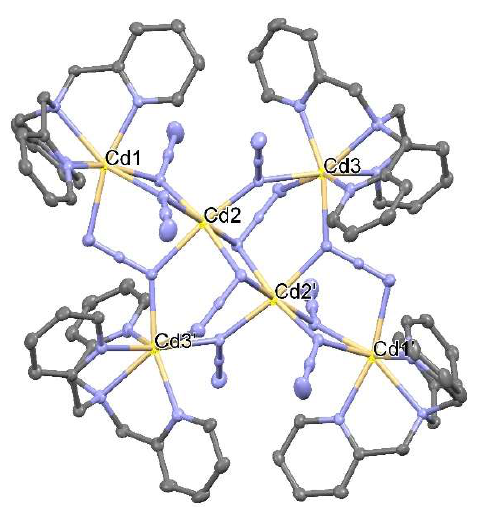
Figure 1. Molecular plot of [Cd 6 (TPA) 4 (μ 3 -1,1,3-N 3 ) 4 (μ 2 -1,1-N 3 ) 6 ] 2+ cluster unit. Symmetry code (‘): 1 − x, 1 − y, 1 − z.